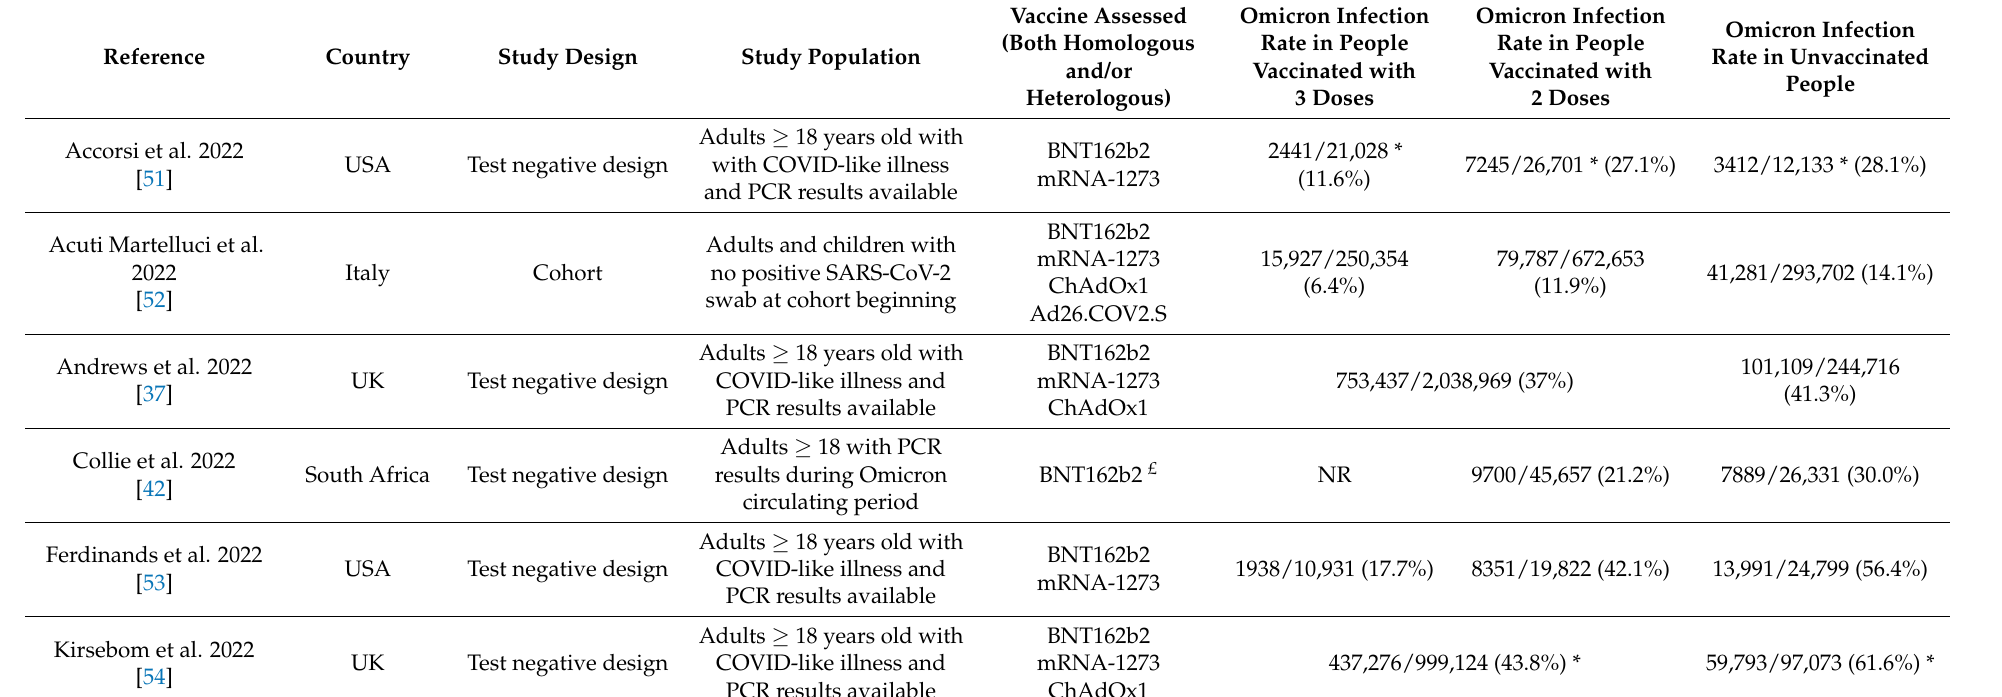
Table 2. Main studies assessing real-life vaccine effectiveness against